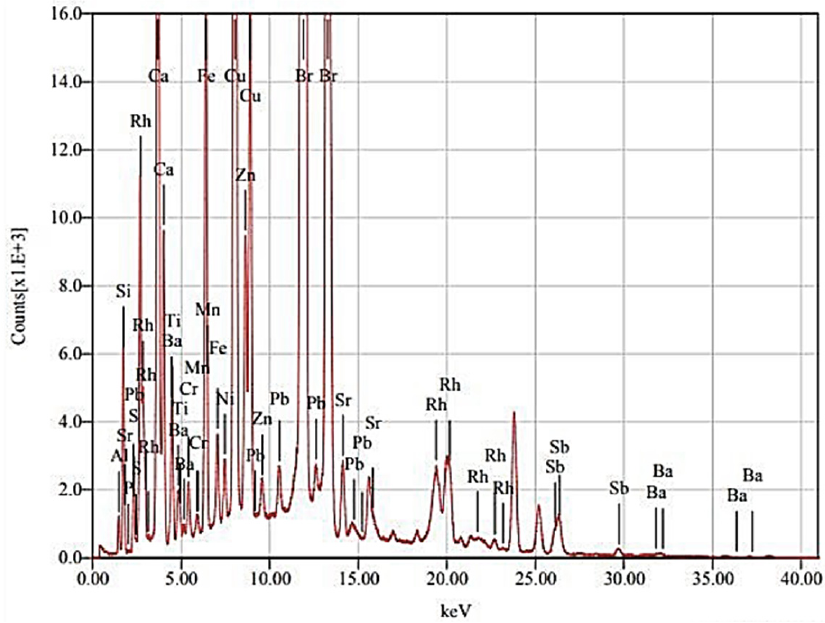
Figure 3. XRF spectrum of the NC2 fraction.